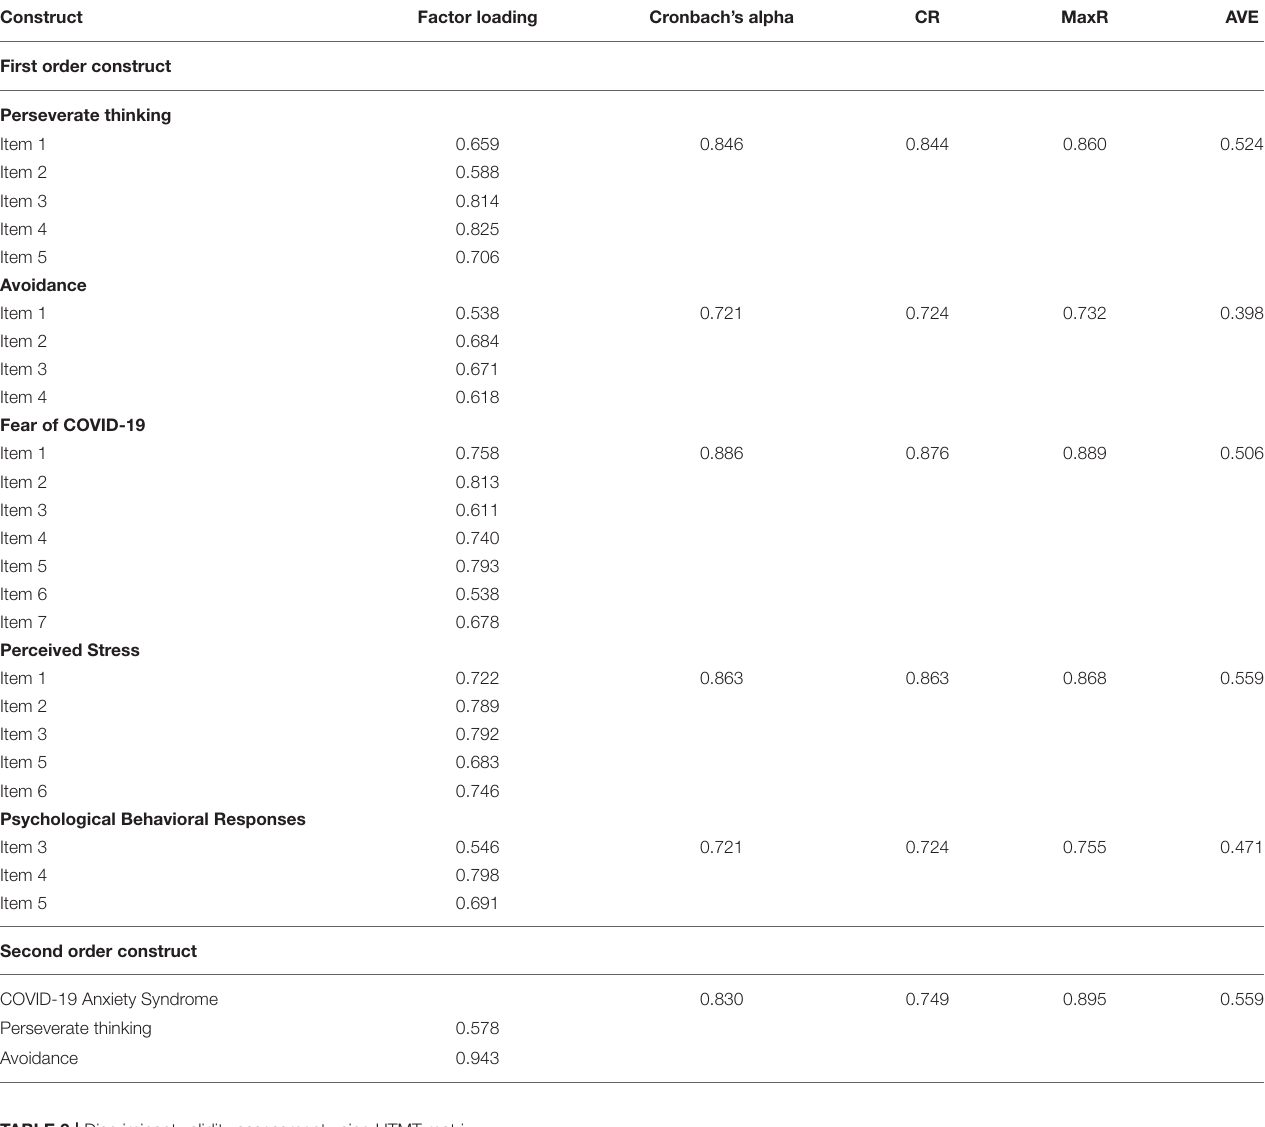
TABLE 2 | Results of the Measurement model assessment.